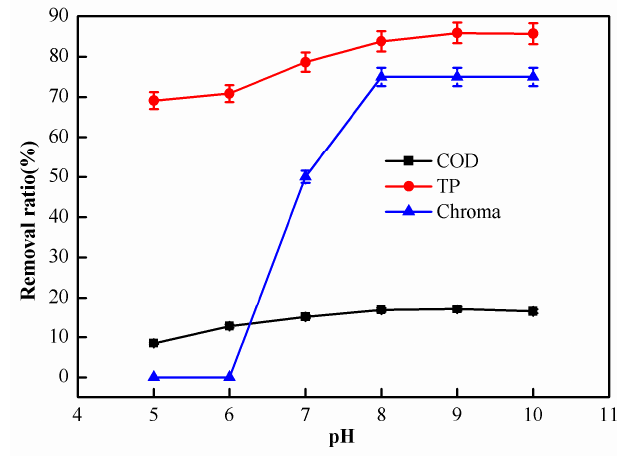
Figure 2. Effect of pH on coagulation performance.